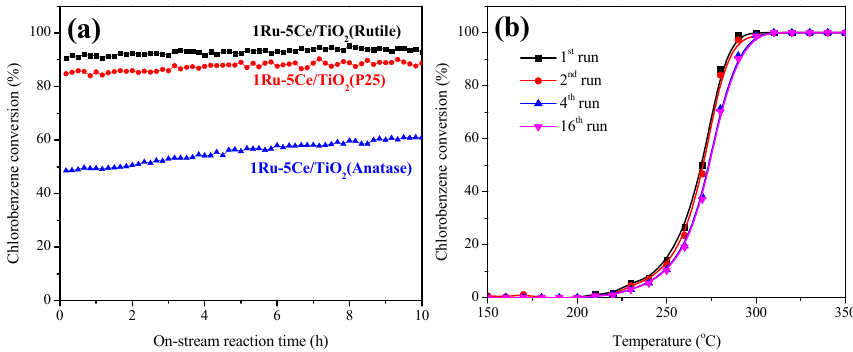
Figure 4. ( a ) Chlorobenzene conversion as a function of on ‐ stream reaction time at 280 °C over the 1Ru ‐ 5Ce/TiO 2 catalysts; ( b ) cycle experiments over 1Ru ‐ 5Ce/TiO 2 (Rutile) under the conditions of chlorobenzene concentration = 500 ppm, chlorobenzene/O 2 molar ratio = 1/400, and WHSV = 60,000 mL/(g h).